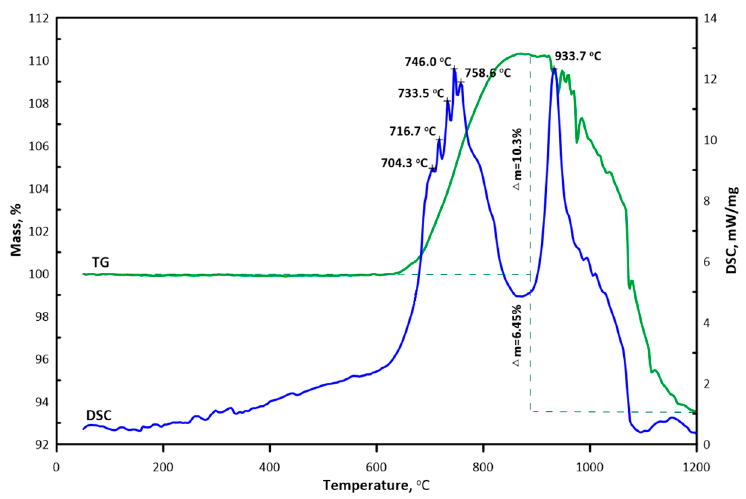
Figure 5. TG-DSC curves of (Hf,Zr,Ti,Nb,Mo)C ceramic in the 25–1200 ◦ C range. The oxide layer formed on the surface of (Hf,Zr,Ti,Nb,Mo)C ceramic after the high- temperature diffraction was presented by grains of various morphologies, including small oxide phase nuclei with a spherical shape, individual crystals with elongated and irregular shape (Figure 6a). EDS analysis demonstrated the following content of metal elements: Nb (8.01 at.%), Ti (4.98 at.%), Zr (4.98 at %), Hf (3.19 at.%), Mo (1.01 at.%) (Table 1).